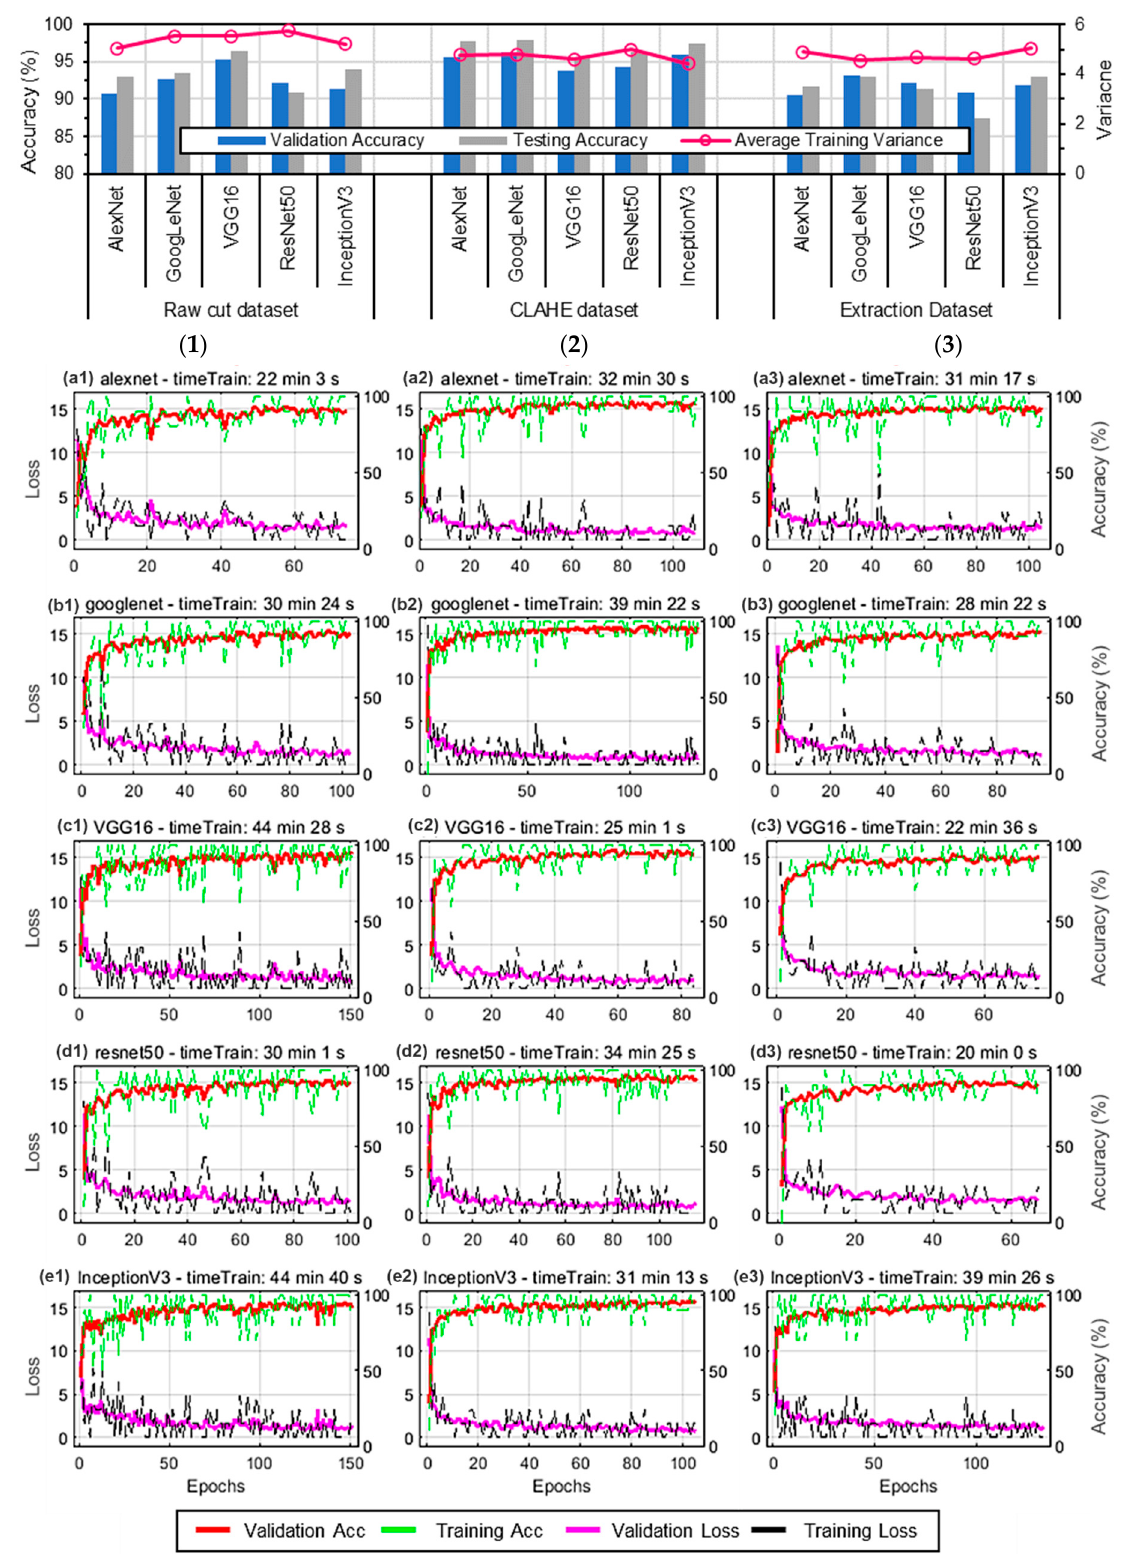
Figure 8. Plots of training and validation performance from three variation dataset on five pretrained architecture using transfer learning approach in deep CNN: ( 1 ) raw image dataset, ( 2 ) CLAHE image dataset, and ( 3 ) extraction image dataset.